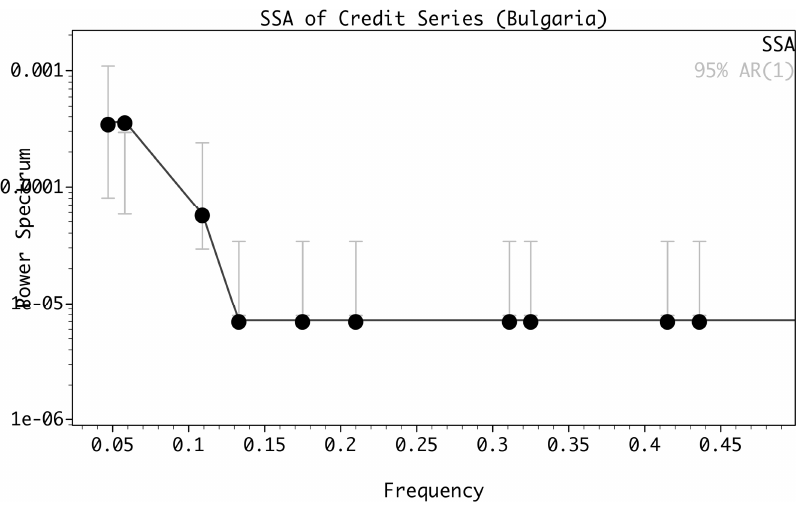
Figure 3. Singular Spectrum Analysis (SSA) of Credit